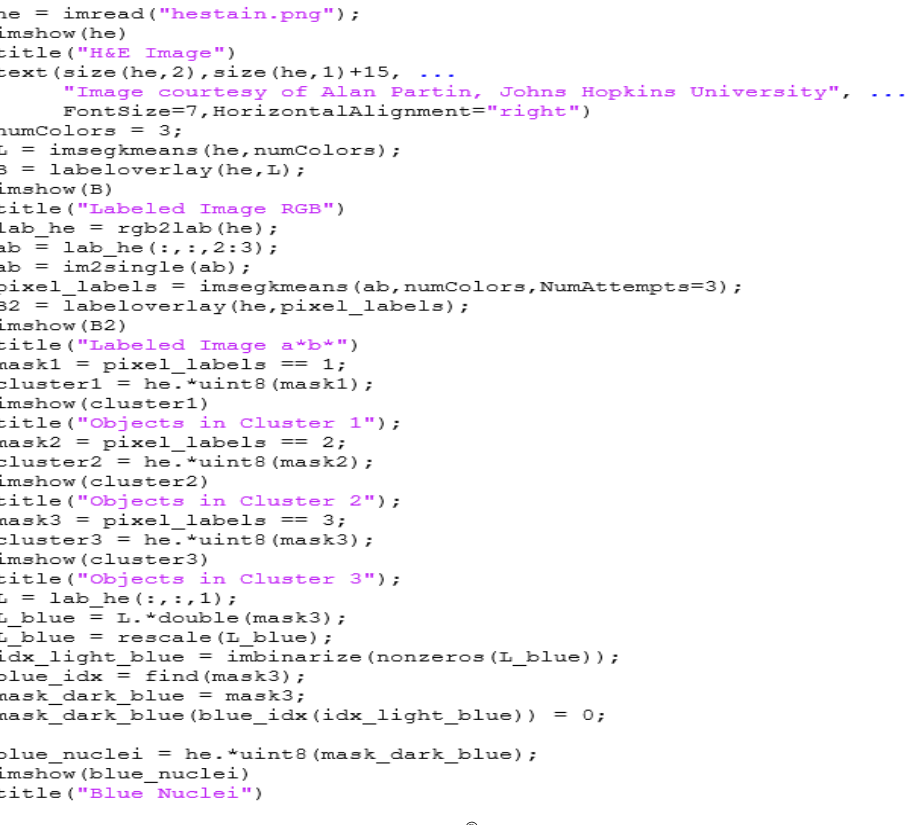
Figure 4. Image analysis code used for MATLAB ® .